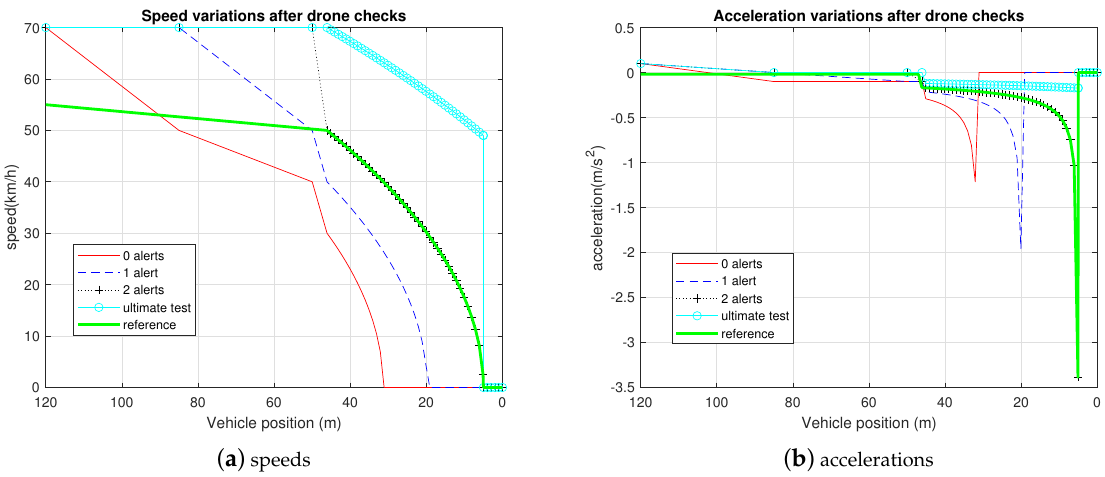
Figure 9. Speeds and accelerations of driver type 2, case of wet straight